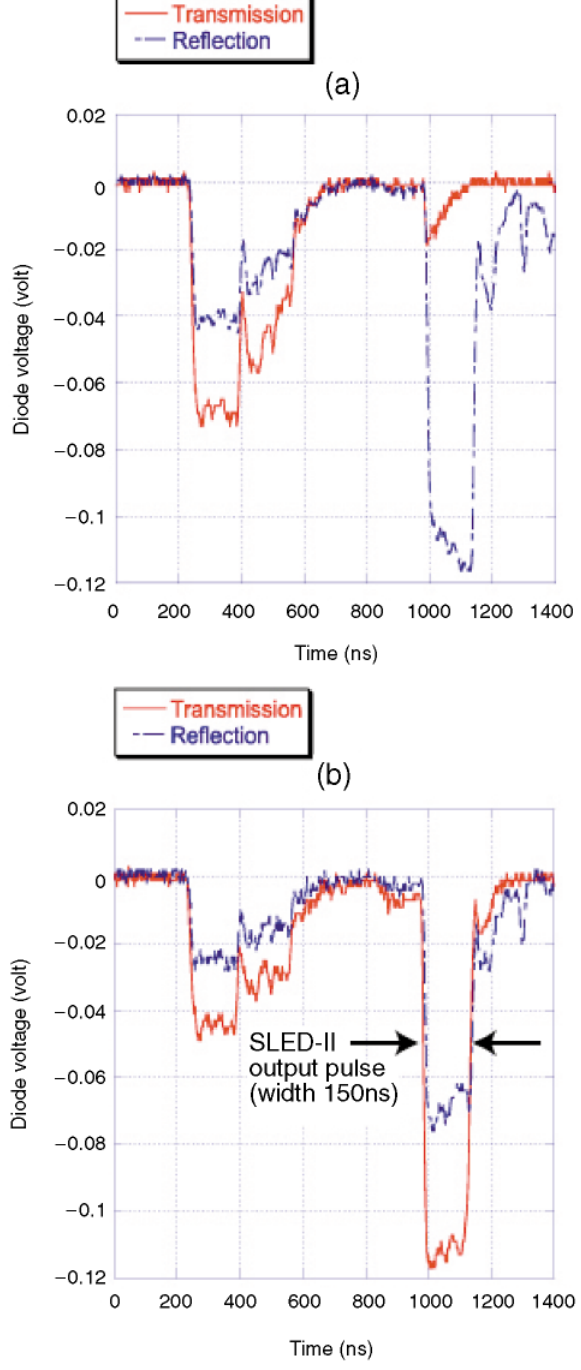
FIG. 22. (Color) Typical waveforms of reflected and transmitted rf signals when arc occurred. Bottom graph (b) shows waveform without arcing (metal-only